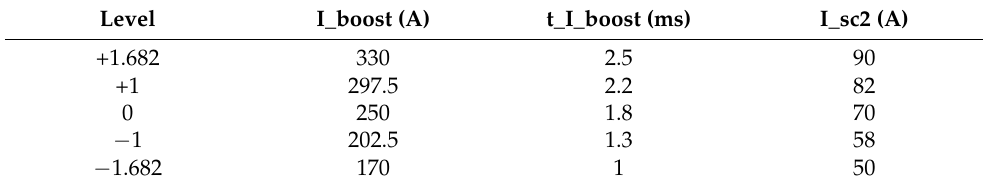
Table 5. Variables and levels for the CMT characteristic parameters.